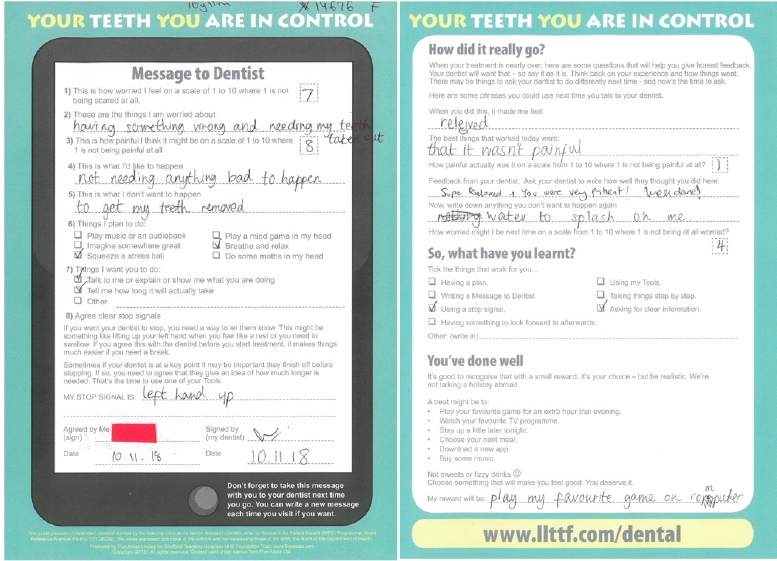
Figure 1. An image of a completed ‘Message to Dentist’ proforma, including the front and back pages.